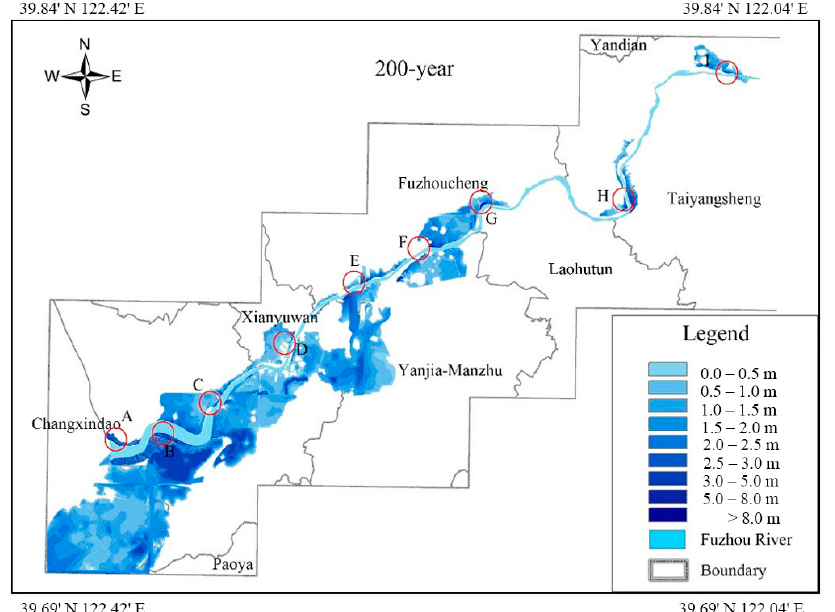
Figure 15. Submerged depth of 200-year return period scenario (Depth in here means maximum depth of the same point during the total flood depth of the same point during the total flood process).